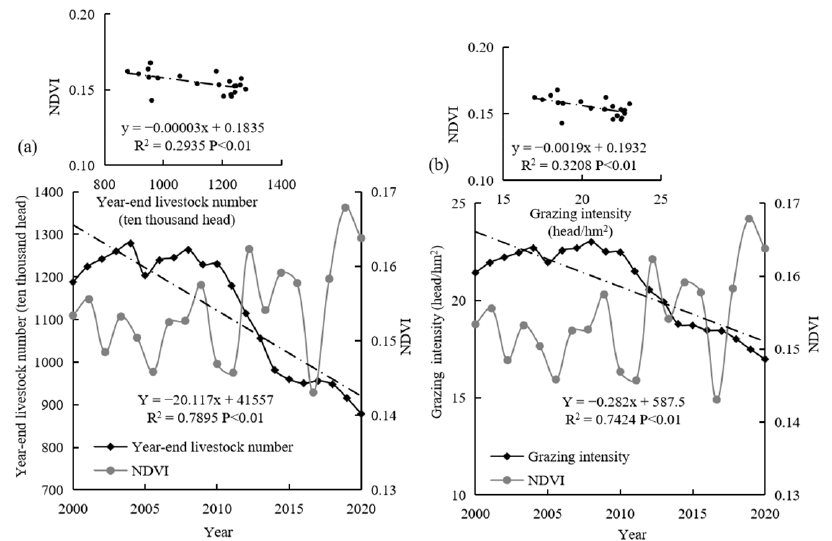
Figure 8. Interannual variation of the year-end livestock number ( a ) and grazing intensity ( b ) in the SWTP from 2000 to 2020.